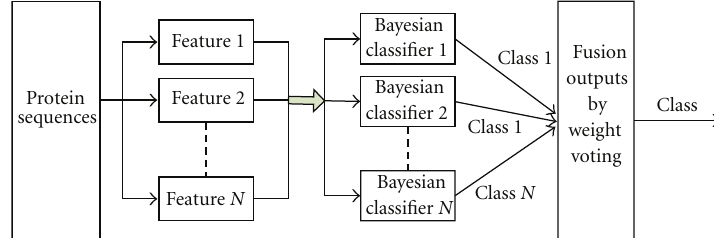
Figure 5: Integrated classification model used in this paper.